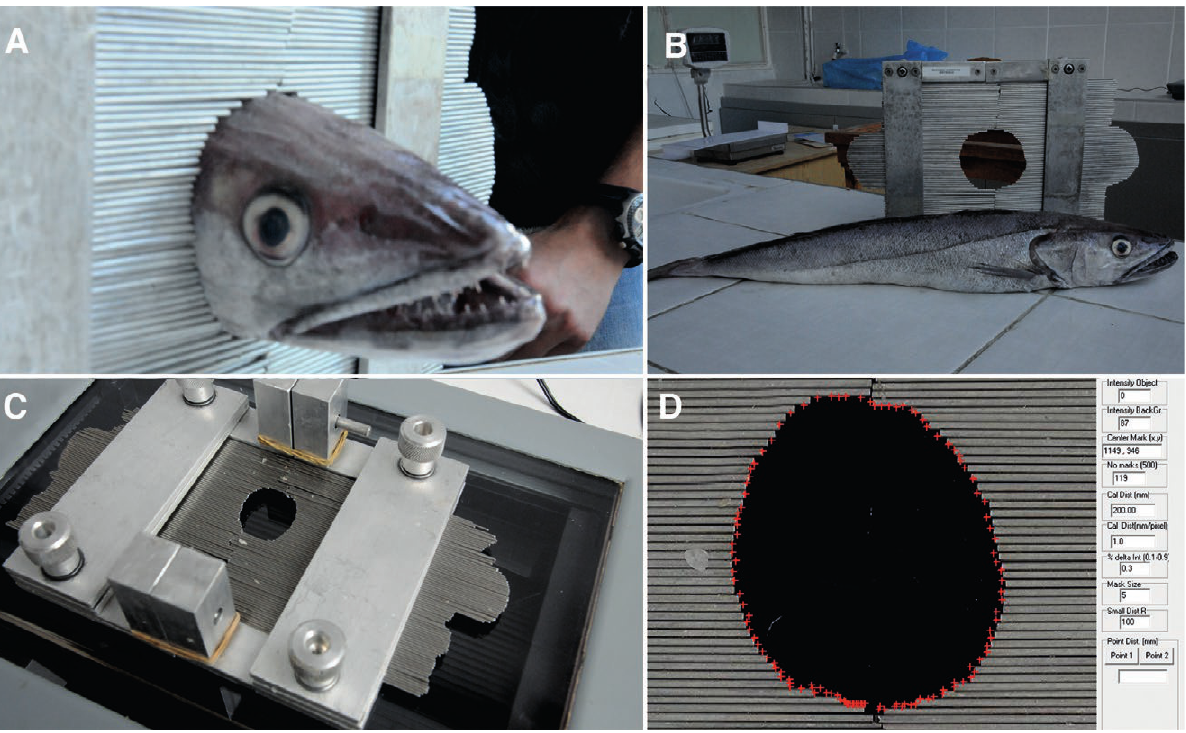
Fig. 2. – Extraction of cross-section shapes (CS) for a randomly selected hake ( Merluccius merluccius ). A, a hake ( Merluccius merluccius ) positioned in a morphometer at cross-section. B, the cross-section (CS) shape extracted by the morphometer. C, the morphometer is placed in a flatbed scanner for digitizing the shape into a computer image. D, the computer image of edge detection of